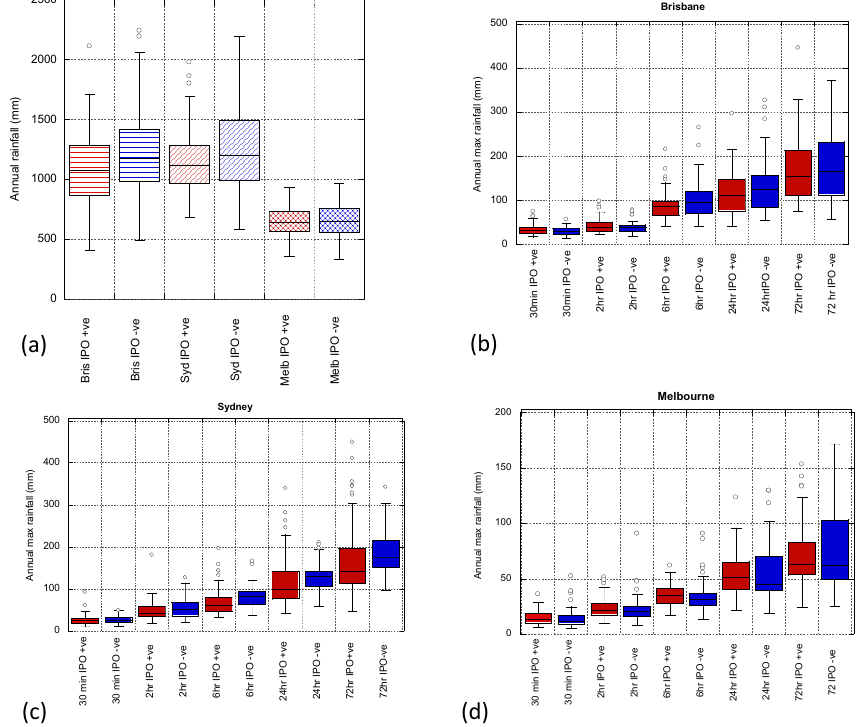
Figure 6. Relationship between IPO and (a) total annual rainfall, and annual maximum rainfall at various durations for (b) Brisbane, (c) Syd- ney, and (d)